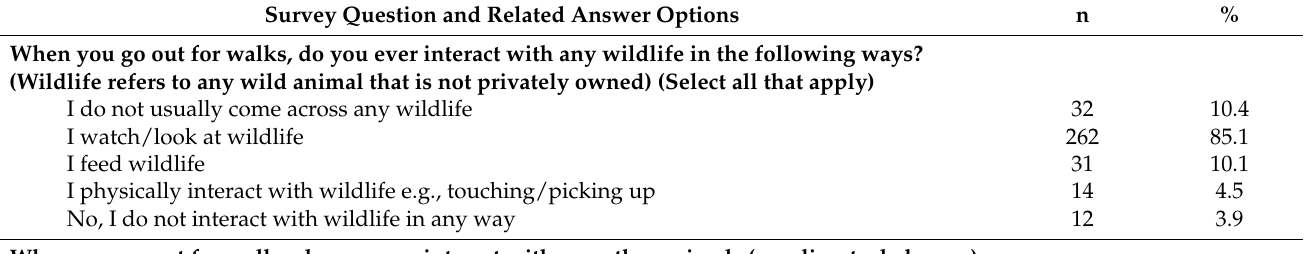
Table 3. Interactions with animals, including wildlife, horses and livestock, on walks as reported by respondents. Survey Question and Related Answer